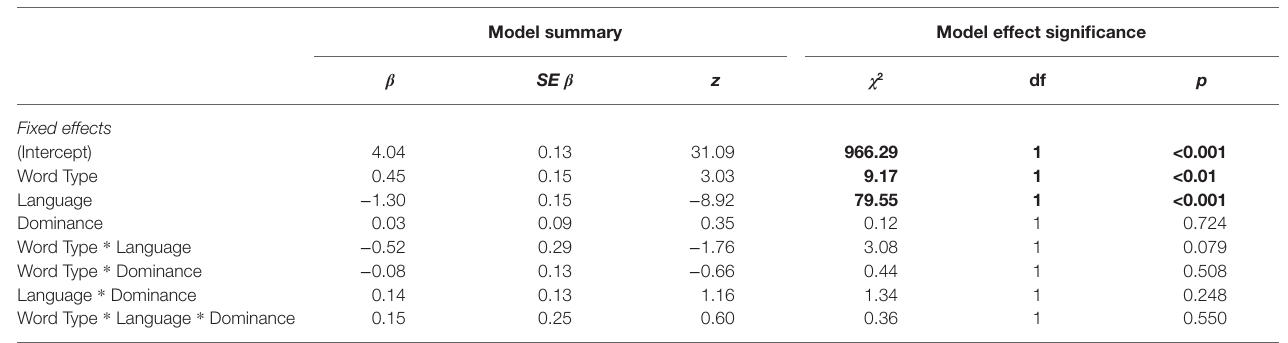
TABLE 3 | Results of logistic mixed effects model on accuracy data in the lexical decision